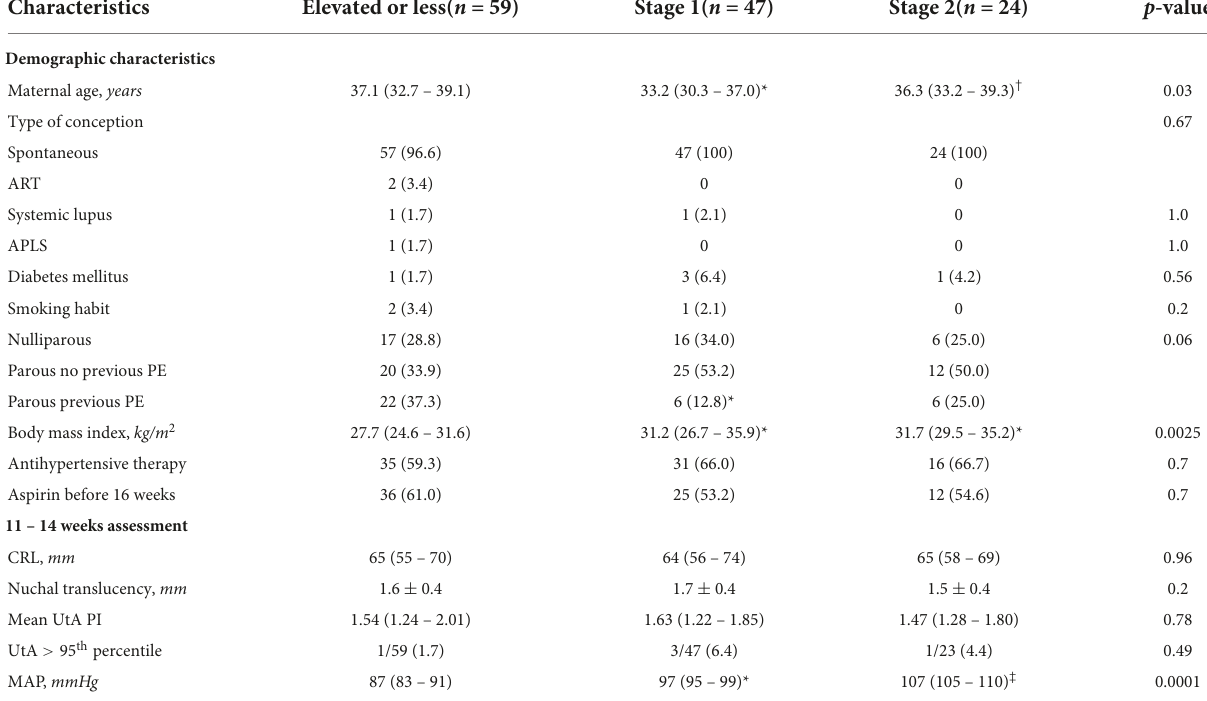
TABLE 1 Demographic characteristics of pregestational hypertensive pregnancies at 11–14 week scan.